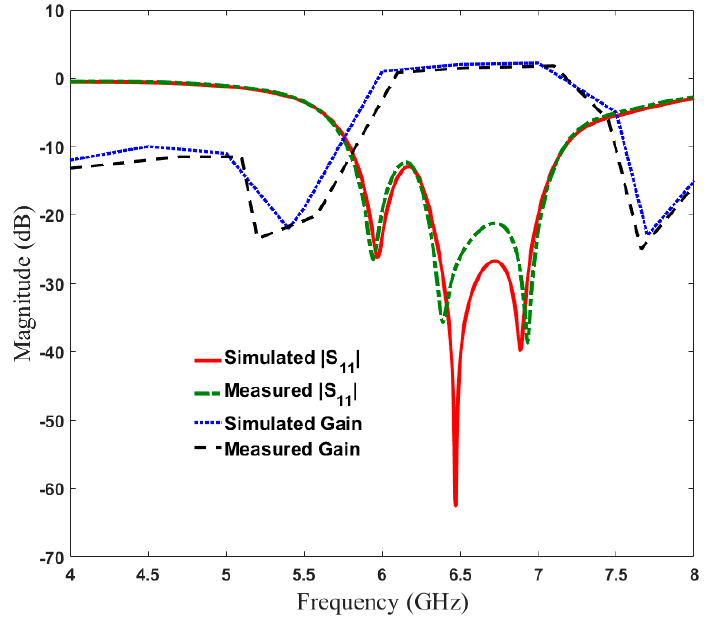
Figure 6. S11 ‐ parameter and gain of the proposed filtering antenna.